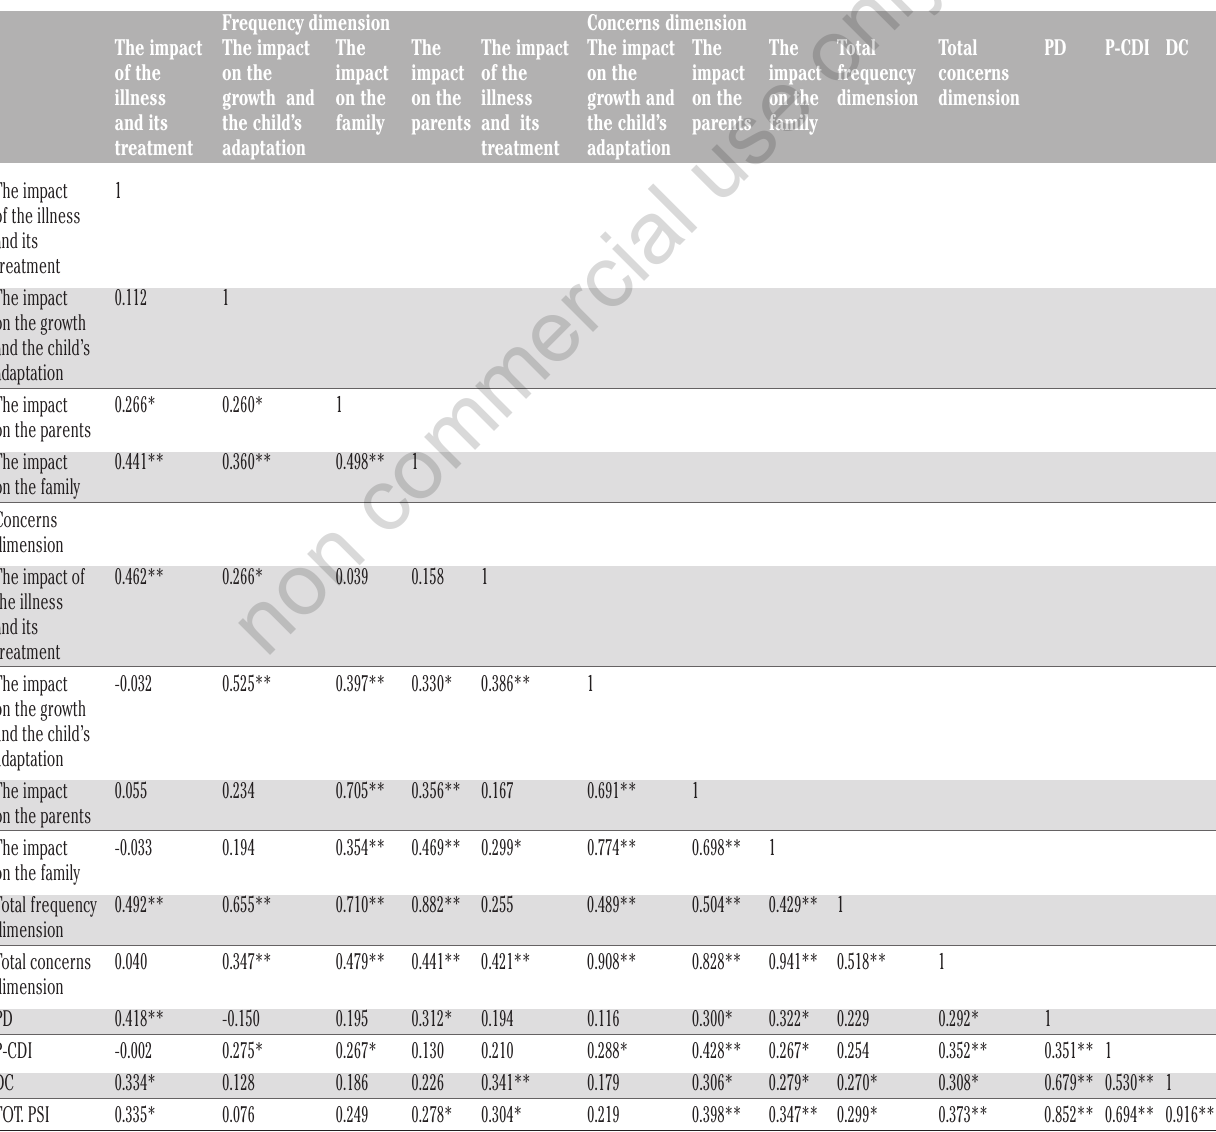
Table 2. Correlations between the two ICIS subscales dimensions, and between PSI-SF and ICIS scores reported by parents with CD children